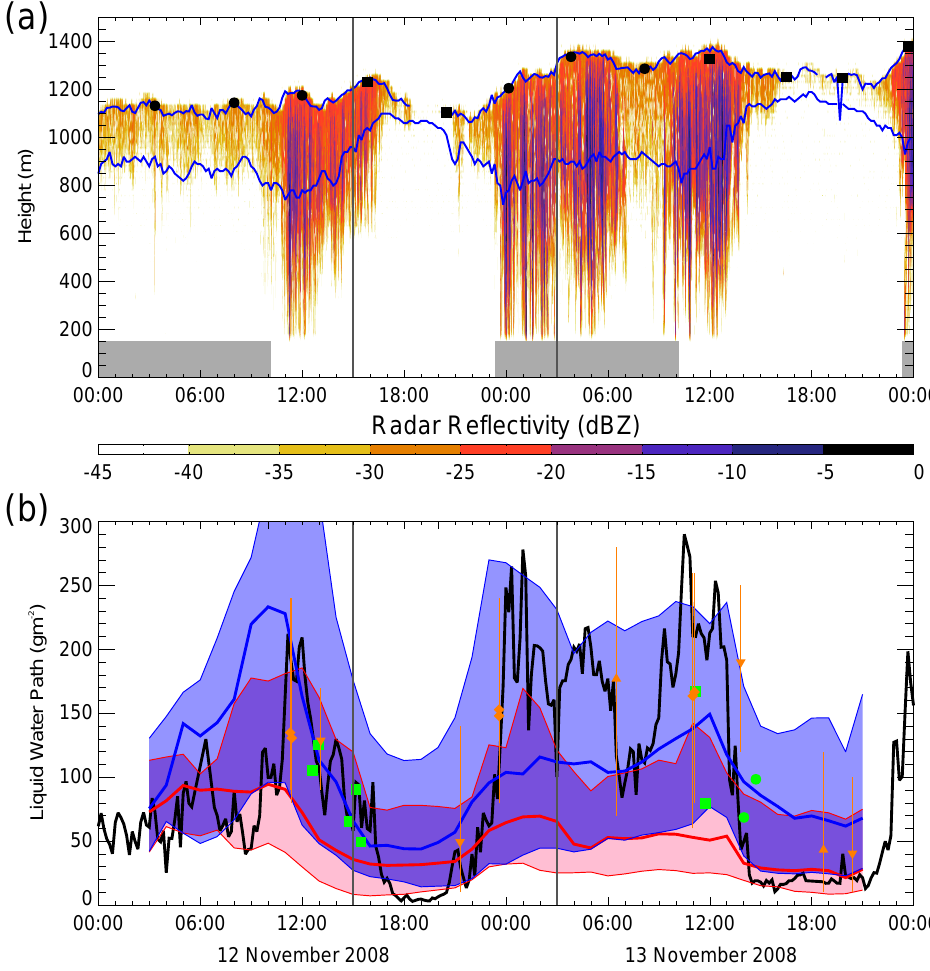
Fig. 2. (a) Radar reflectivity factor (dBZ) from the Ron Brown W-band radar during 12 and 13 November 2008, with cloud base and top (blue) obtained from the ceilometer and radar, respectively. Black symbols represent the radiosonde inversion heights, with circles representing well-mixed profiles and squares decoupled profiles. The grey shading marks night-time, as defined by an absence of downwelling short-wave radiation measured at the Ron Brown. (b) Liquid water path from the Ron Brown microwave radiometer (black), from the BAe-146 (green squares), C-130 (green circles), AMSR-E (orange upward triangles), SSMI (orange diamonds) and TMI (orange downward triangles). The aircraft profiles are within 2 ◦ of the ship and the satellite observations are a mean over a 2 ◦ region surrounding the Ron Brown, with the bars showing the range of values. Over plotted are the median and 5th/95th percentiles from a 1 ◦ region surrounding the Ron Brown, for the 1km control (red) and modified microphysics (blue) simulations. The grey vertical lines show the times of the plots in Figs. 3, 4, 5, 6 and 8.